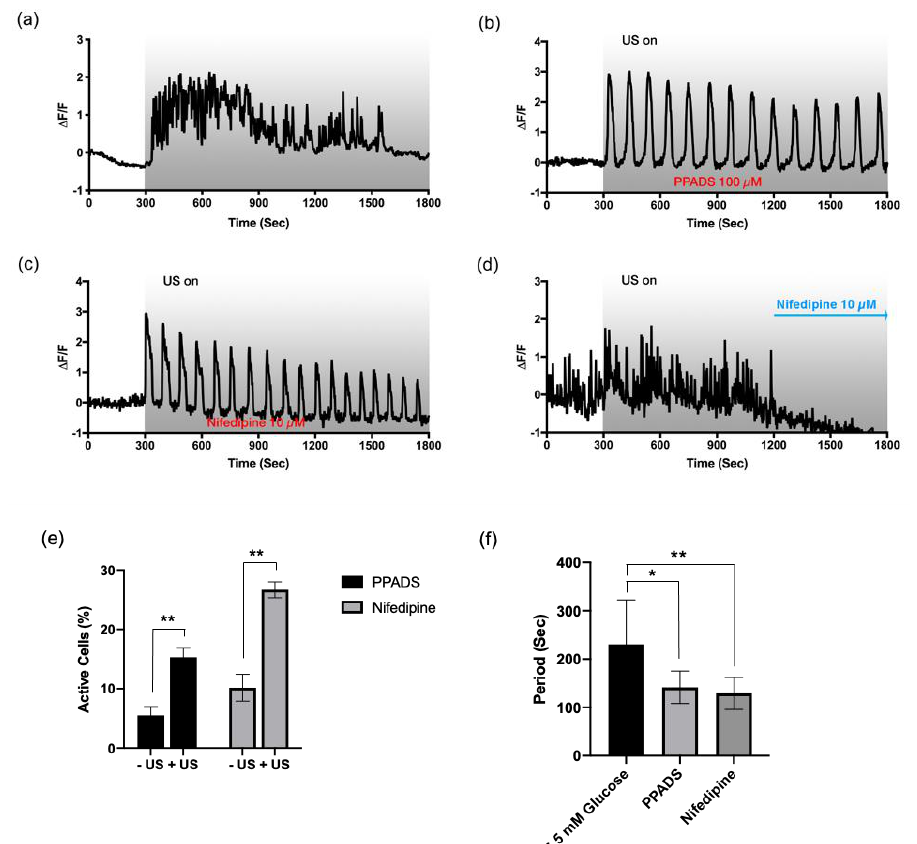
Figure 4. Fast and irregular Ca 2 + oscillations depend on L-type voltage-dependent Ca 2 + channels coupled to P 2 X purinergic receptors. Ultrasound-evoked Ca 2 + dynamic profiles from the HIT-T15 cells ( a ) without drug (control), or in the presence of ( b ) pyridoxalphosphate-6-azophenyl-2 (cid:48) ,4 (cid:48) -disulfonic acid (PPADS) (100 µ M, pretreated), ( c ) nifedipine (10 µ M, pre-treated), and ( d ) nifedipine (10 µ M,